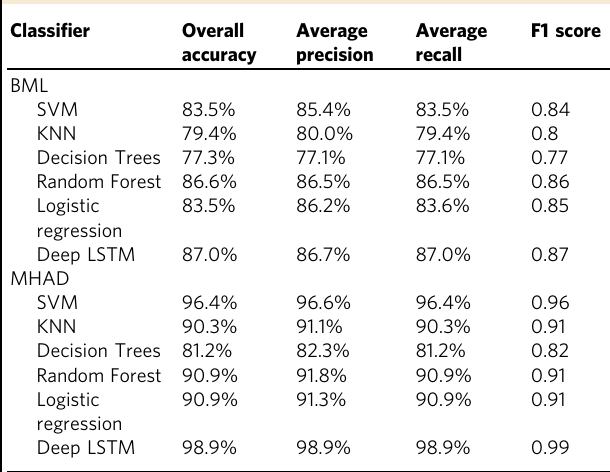
Table 1 Performance